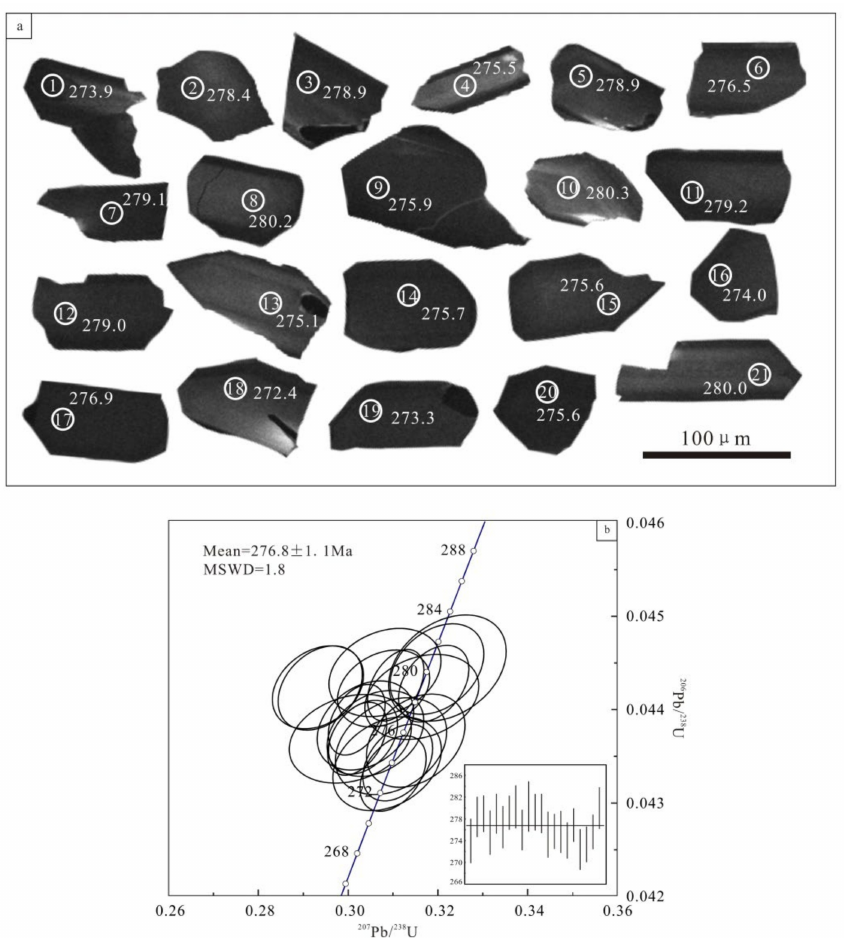
Figure 4. ( a ) Cathodoluminescence images of selected zircon crystals from Baixintan olivine gabbro (BXT-B18); ( b ) Zircon U-Pb isotope concordia plot. Circles are analytical positions, and numbers are 206 Pb/ 238 U ages (in the unit of